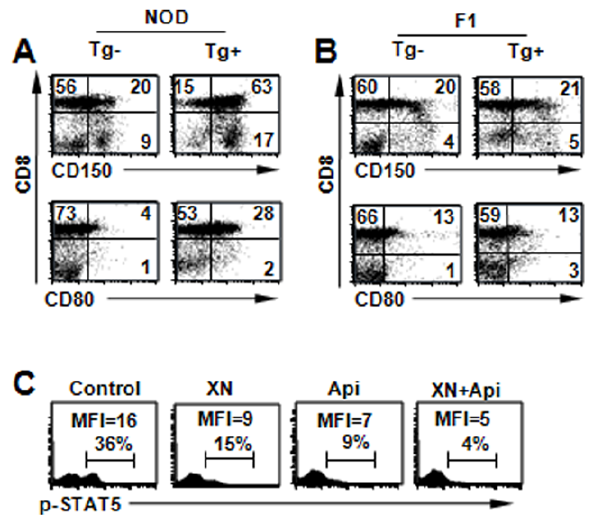
Figure 4. Expression of costimulatory molecules CD150, CD80 in Stat5b transgenic lines. (A) CD150 and CD80 are increased on the surface of CD8 + thymocytes even before the development of lymphoma. Shown are data from a NOD.Stat5 Tg mouse (Tg + ) and a littermate control (Tg 2 ) at 6 weeks of age. P , 0.01, compared with that of littermate controls. (B) CD150 and CD80 are not significantly different between transgenic F1 mice and littermate controls at 6 weeks of age. P . 0.05, compared with that of littermate controls. (C) p-STAT5 levels after two weeks of treatment with Apigenin and Xanthohumol alone or in combination. Data for thymus of the treated mice (12 weeks of age) are shown here. Representative data are shown from 1 of 3 similar